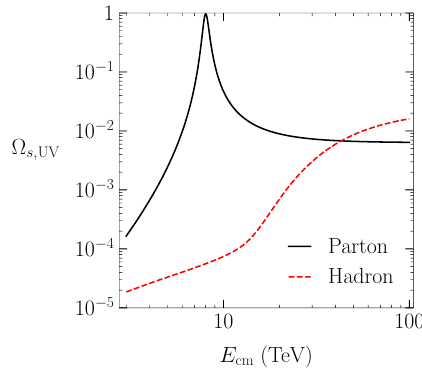
Figure 8 . Ω s, UV computed using the s -channel UV model as a function of the center-of-mass energy E cm . This shows that the UV theory is free of perturbative unitarity violation, when the couplings are taken to be λ q = µ q µ φ /M 2 = 2